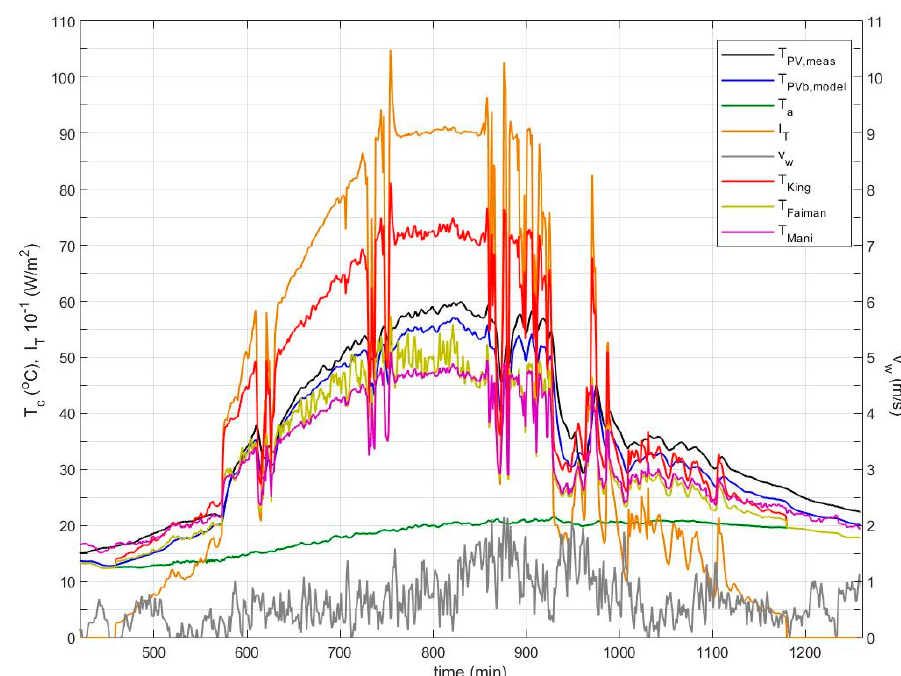
Figure 6. As in Figure 4, during a cloudy day in April, with interval 1 min.